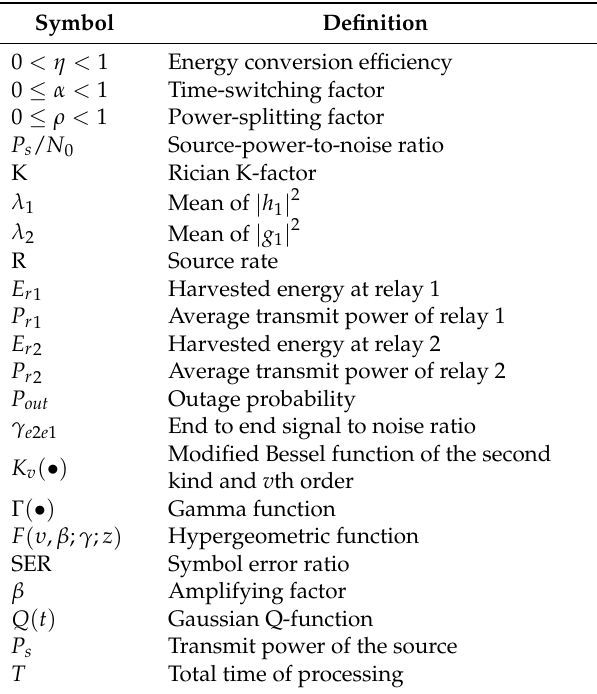
Table 1. All symbols